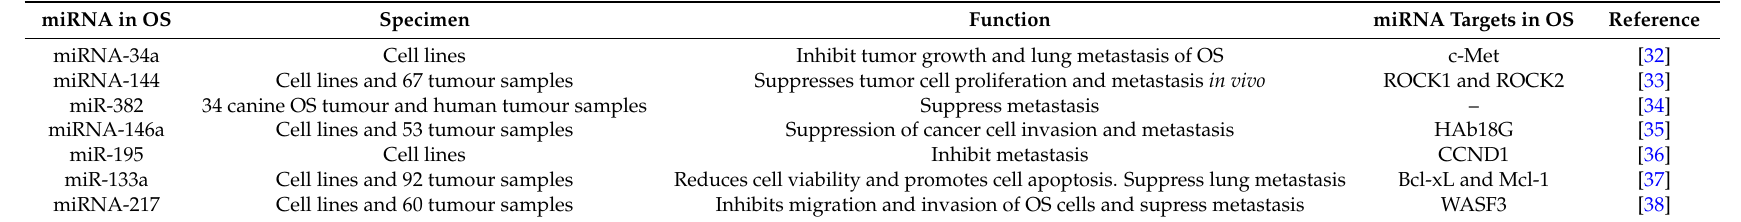
Table 2. List of miRNAs and their target genes involved in anti-metastatic activity of osteosarcoma. miRNA in